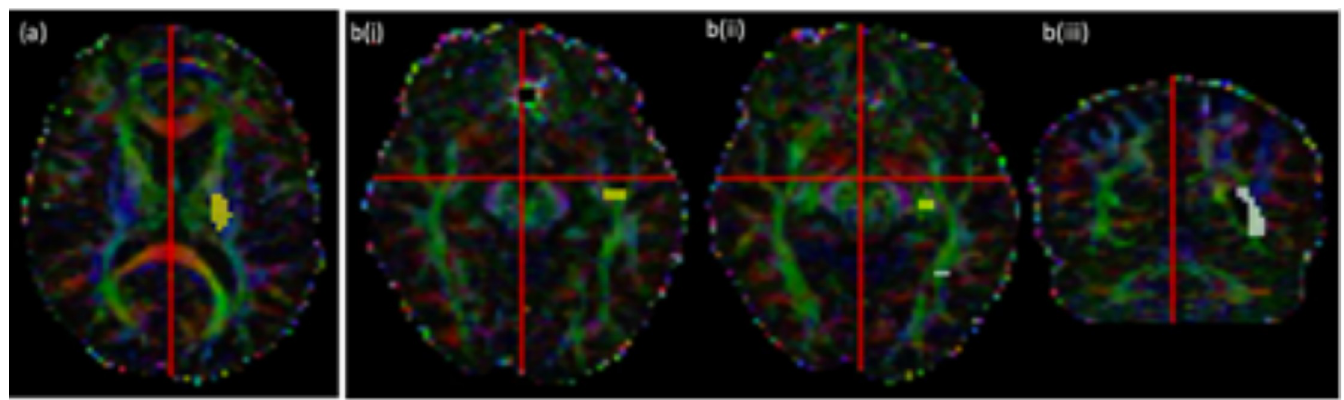
Fig 1. Volunteer subject tractography seed ROI’s (yellow) waypoint ROI’s (white) and exclusion masks (red) for (a) CST and (b) OR at 3 slice locations.